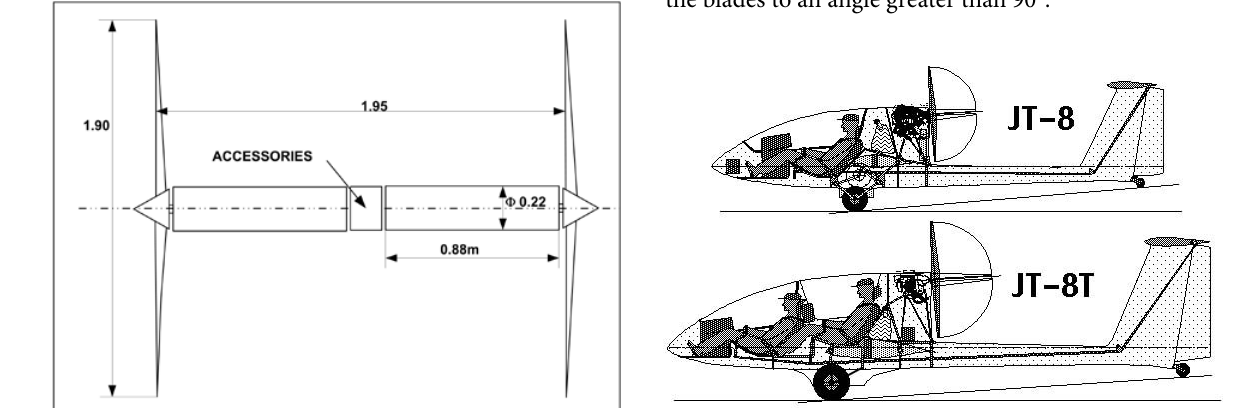
Fig. 5. Two propellers and electric motor-generators in a tandem configuration